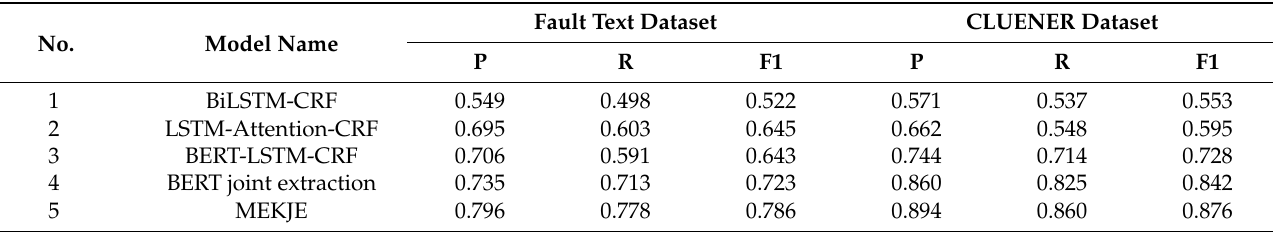
Table 6. Multi-entity Relationship Extraction Prediction.